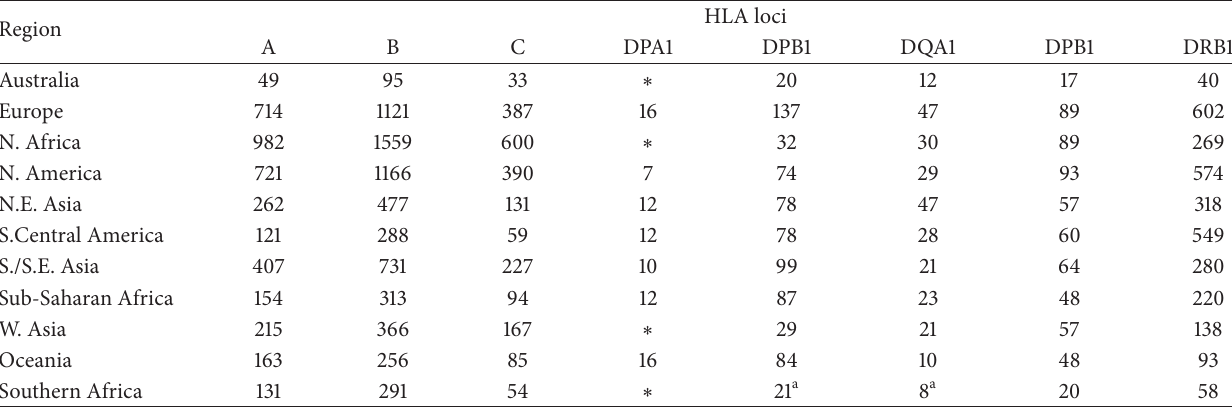
Table 2: Number of classical HLA alleles reported in each geographical region. Sub-Saharan Africa (including southern Africa) generally has a high number of class I alleles (ranked in the top 5 regions) with a low number of class II alleles (ranked in the bottom 5 regions). More than half of the reported class I alleles in sub-Saharan Africa come from southern Africa, with less than half of the reported class II alleles in the sub-Saharan region coming from southern Africa, data from AFND [35, 48]. HLA loci Region A B C DPA1